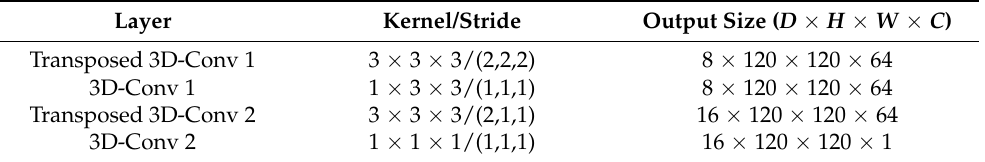
Table 4. Architecture of 3D-CNN in forecaster.